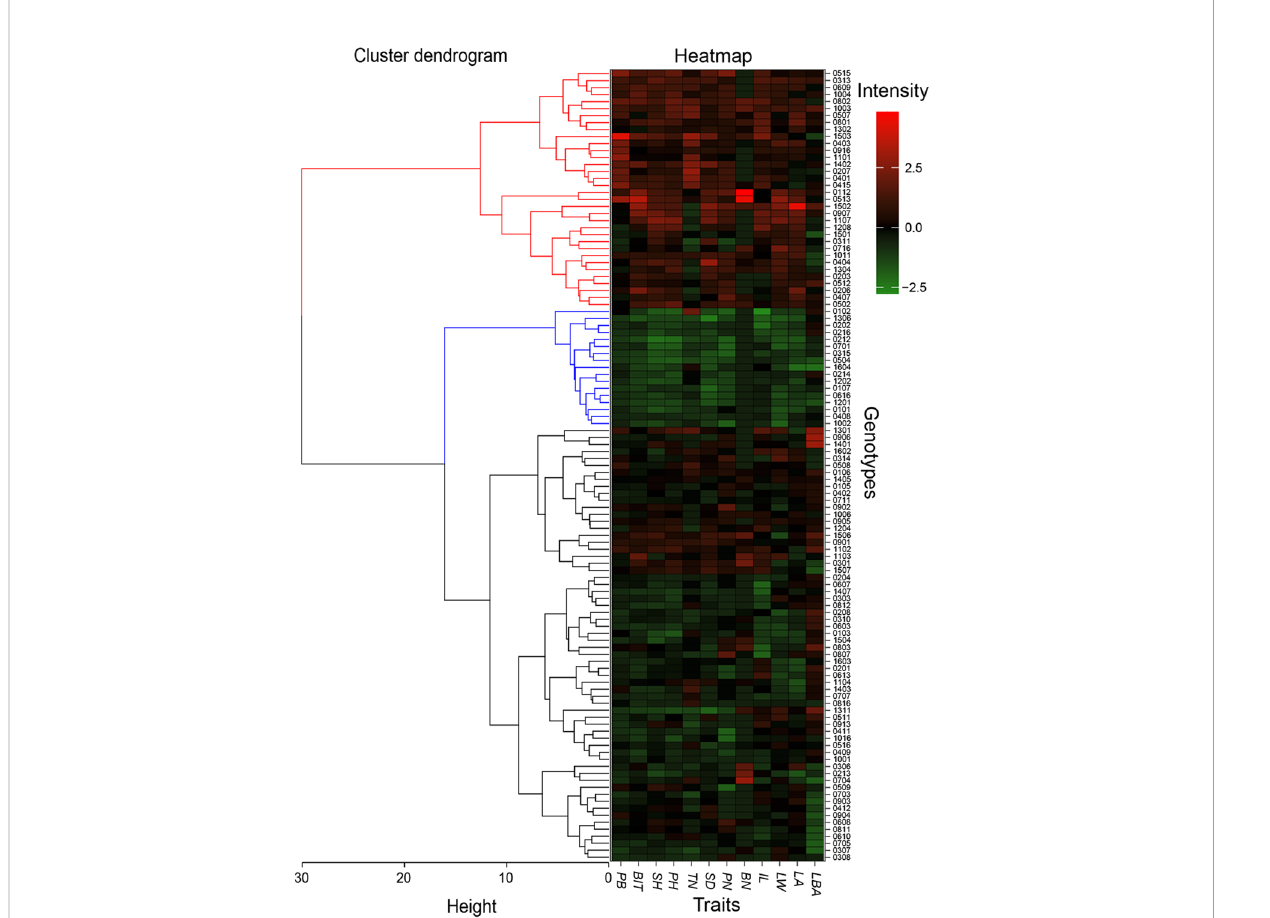
FIGURE 6 Systematic cluster of hybrid genotypes based on growth traits at the end of 2019 growing season. A total of 113 hybrid genotypes are divided into three classes that are showed by using the red, blue, and black lines on the left. The blocks from the red to the green in the heat map represent the good and poor growth performance, respectively. PB , plant biomass; BIT , biomass of individual tiller; SH , stem height; PH , plant height; TN , tiller number; SD , stem diameter; NN , Node number; BN , branch number; IL , internode length; LW , leaf width; LA , leaf area; LBA , leaf basic